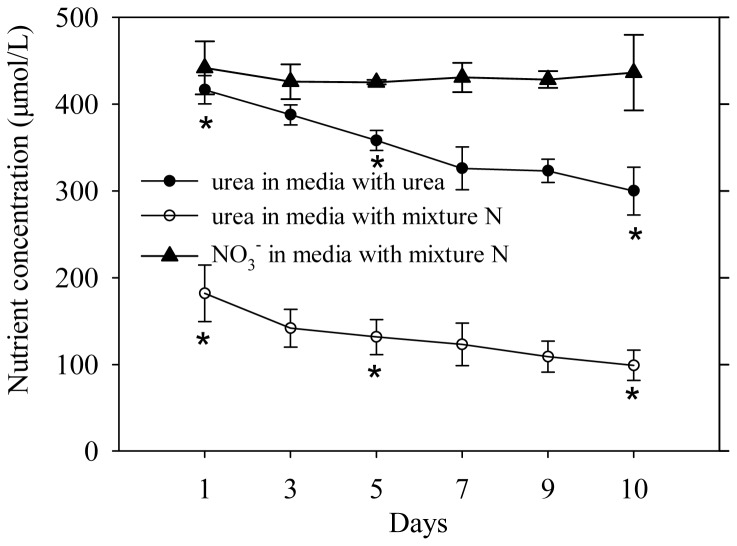
Concentrations of urea and nitrate as a function of culture time in media.Solid triangle represents nitrate concentration in medium with mixture N while solid and open circles represent urea concentrations in media with urea and mixture N, respectively. The difference between time points with asterisk was significant. Significance values were expressed as follows: * P <0.05, ** P <0.001. Error bars represent standard deviation of the mean for the three biological replicates.